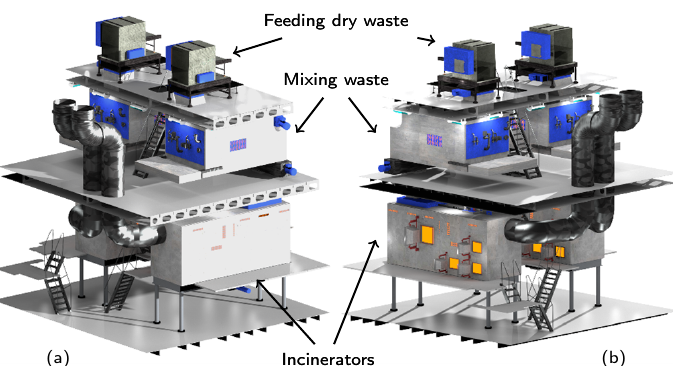
Figure 1. Incineration system, composed of two twin plant. ( a ) front view, ( b ) rear